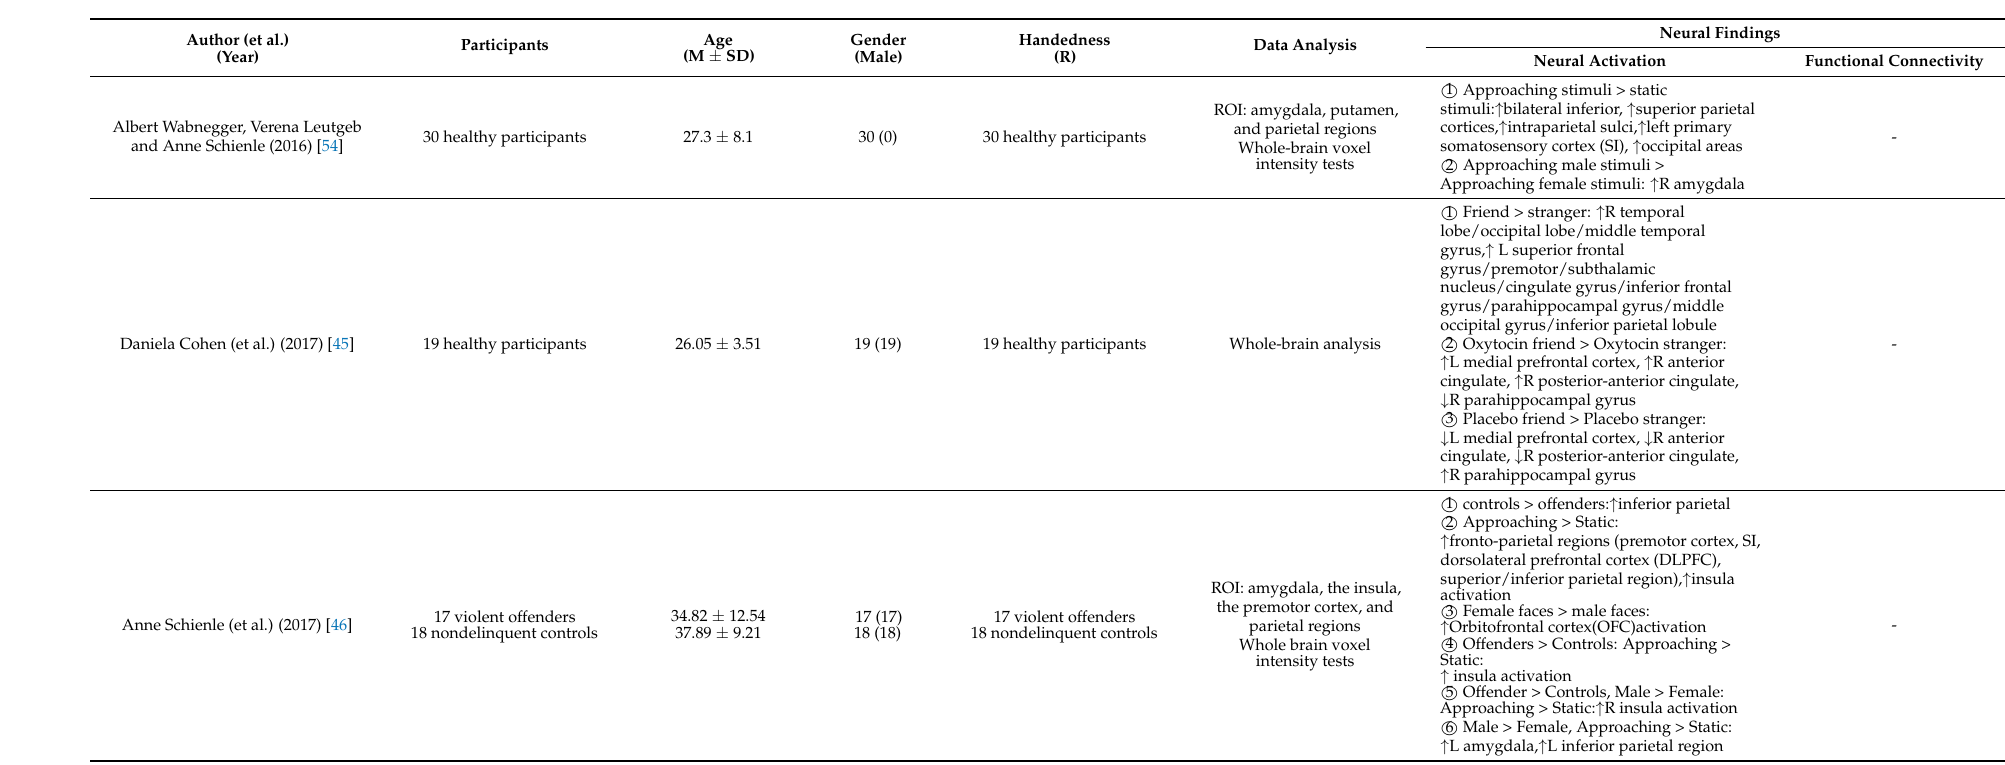
ROI: amygdala, putamen, and parietal regions Whole-brain voxel intensity tests